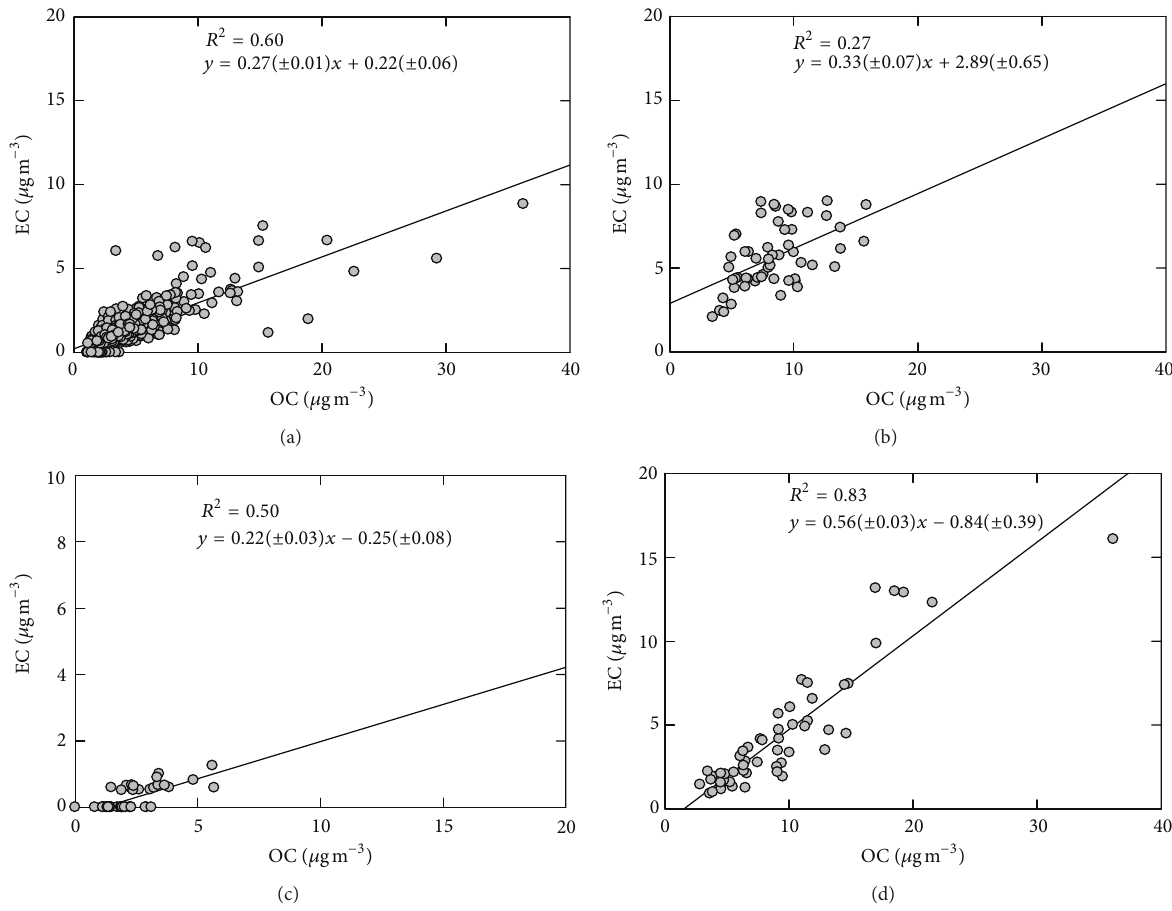
Figure 5: Comparison between OC and EC concentrations (graph (a) includes East Jerusalem, Hebron, Aqaba, Amman, Haifa, Eilat, Tel Aviv, and West Jerusalem; graphs (b, c, and d) indicate Nablus, Rachma, and Zarqa,